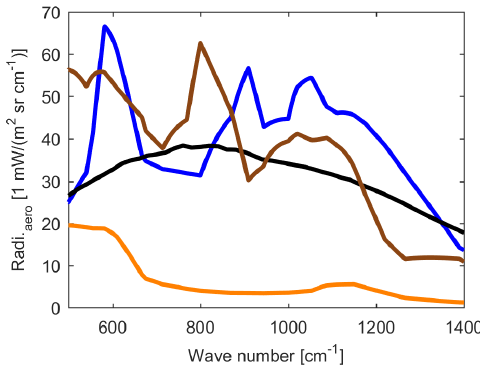
Figure A1. The emission spectra of large aerosol particles (dust – brown, sulfate – blue, sea salt – orange, and BC – black) with a R eff = 0.70µm and a number density = 2000cm − 3 .